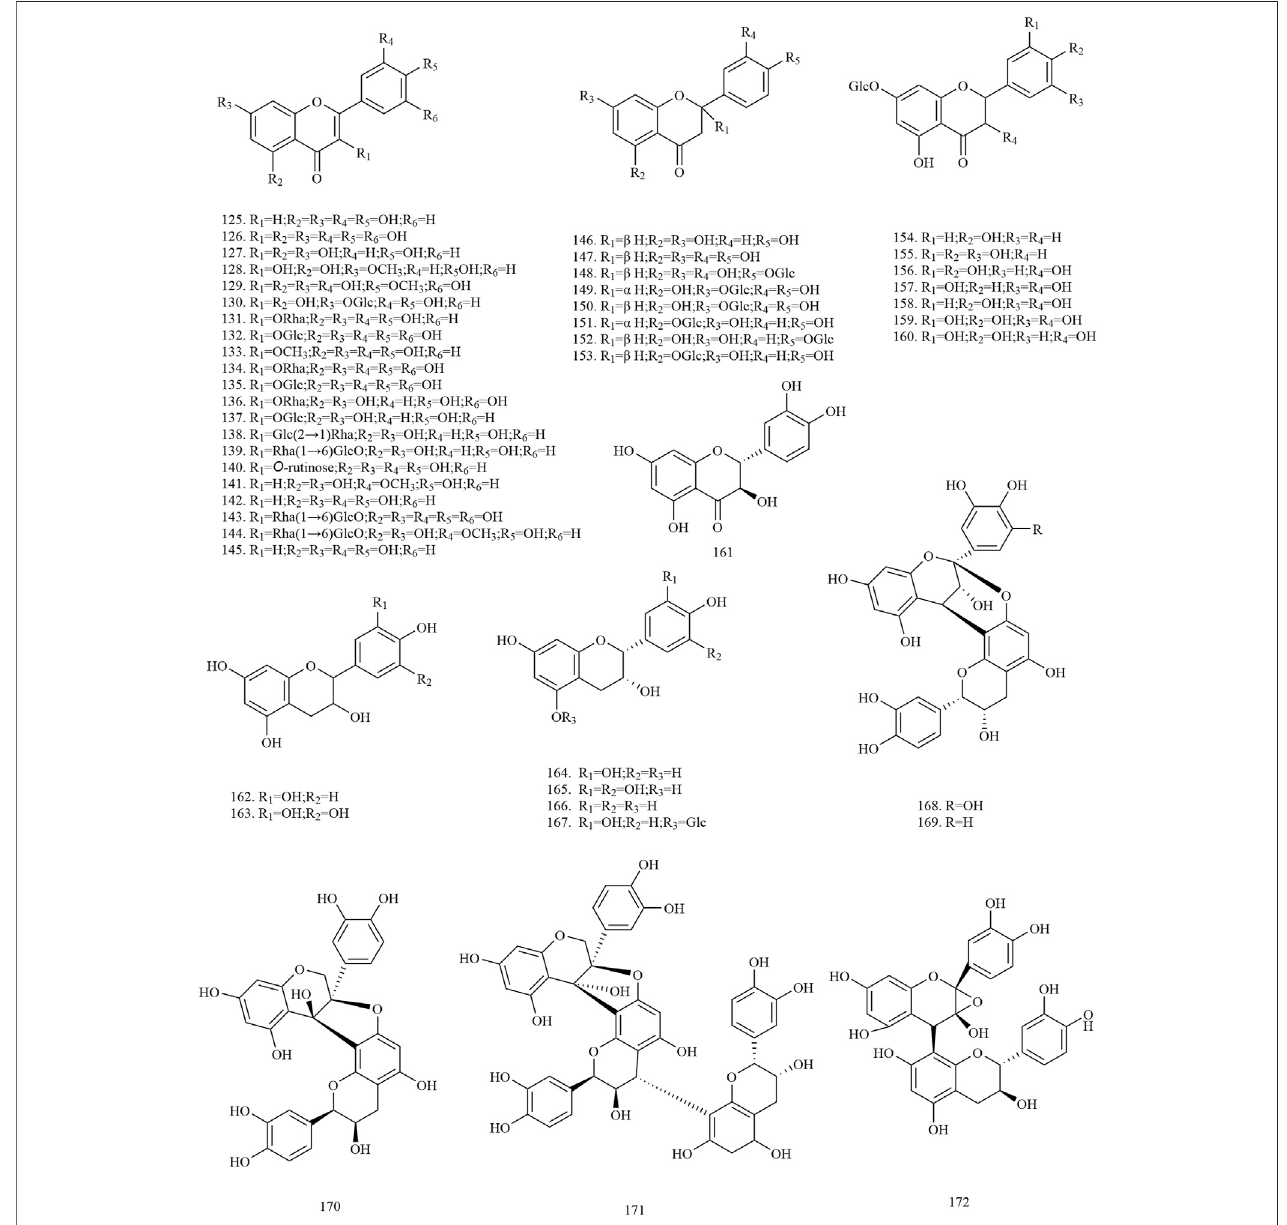
FIGURE 3 | Structures of fl avonoids in X. sorbifolium